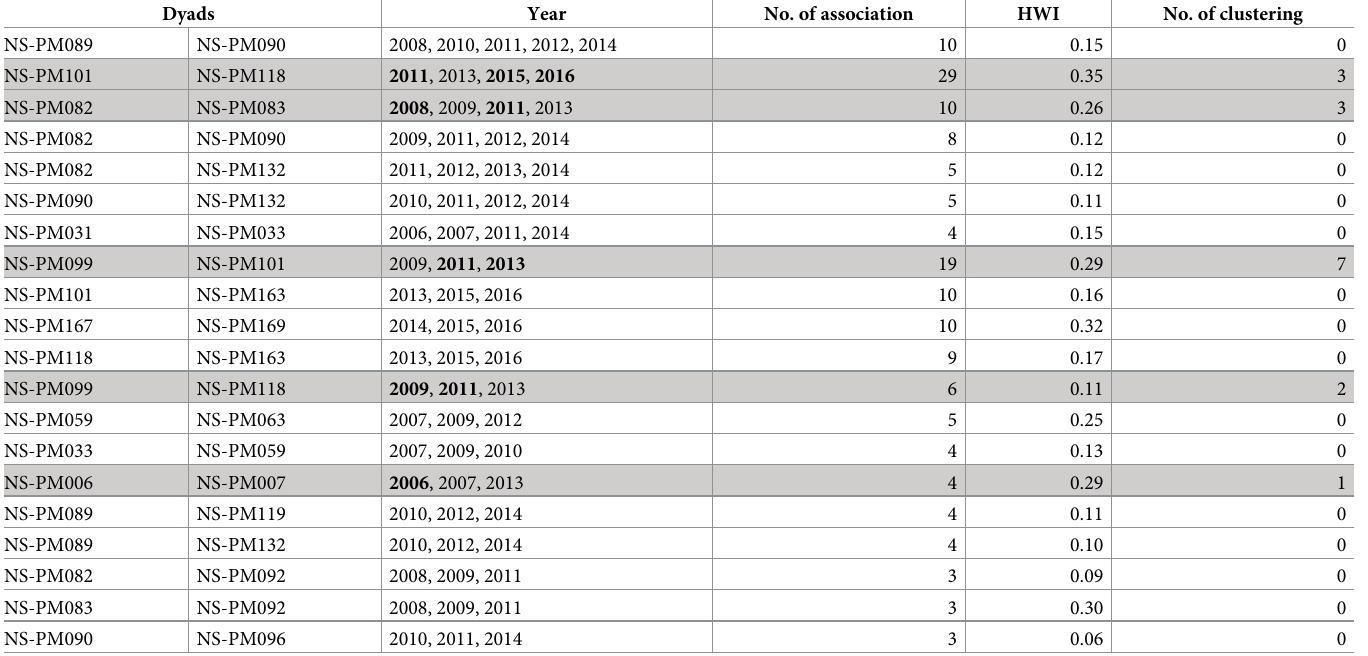
Table 3. Twenty dyads observed associated during more than 2 years.